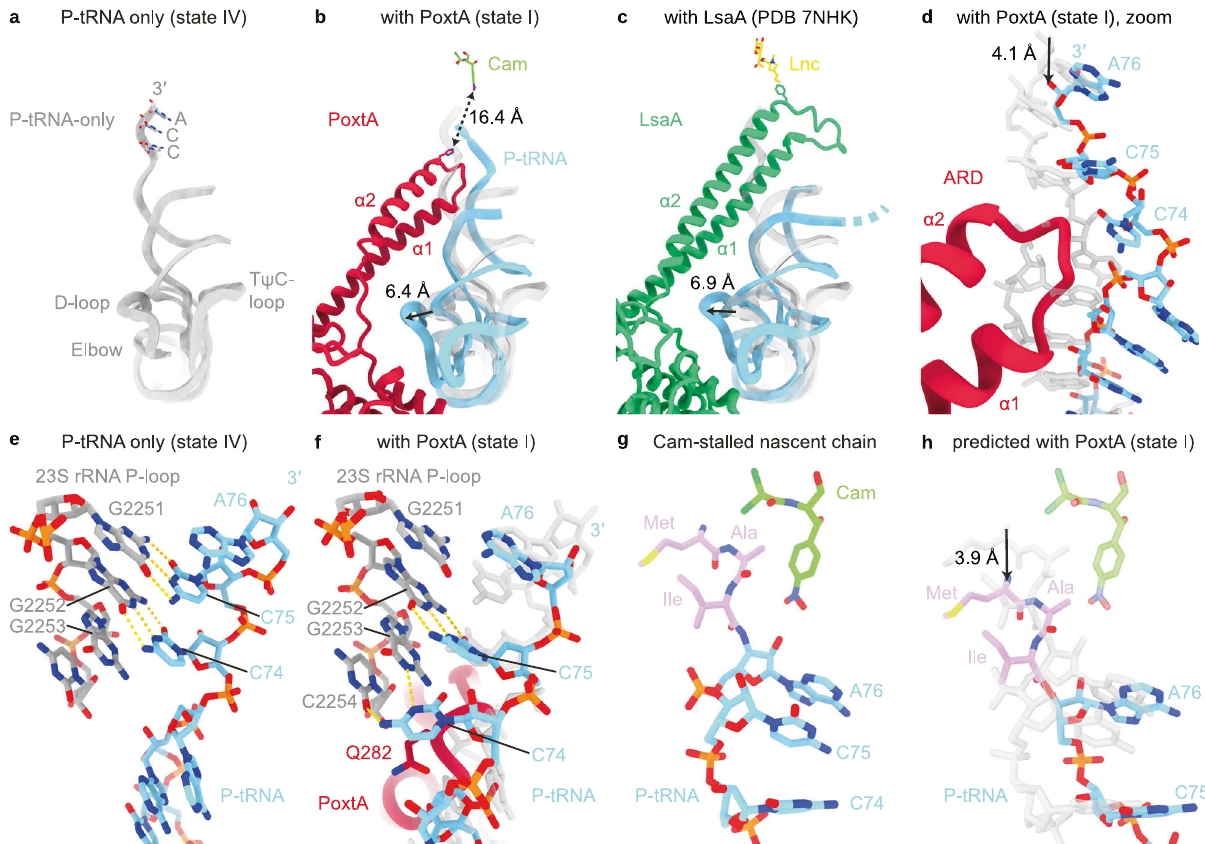
Fig. 5 PoxtA modulates the conformation of the P-tRNA. a – c Comparison of of the P-site tRNA from ( a ) E. faecalis 70S – P-tRNA only complex (grey), ( b ) PoxtA – 70S complex (state I, PoxtA in red and P-tRNA in light blue) and ( c ) LsaA – 70S complex (PDB ID 7NHK 15 , LsaA in green and P-tRNA in light blue). Models of chloramphenicol for PoxtA (PDB ID 6ND5 77 ) and lincomycin for LsaA (PDB ID 5HKV) 78 are superimposed for reference. d close-up of ( b ) showing P-tRNA acceptor stem distortion induced by PoxtA binding. e , f Interaction between the 23S rRNA P-loop (grey) and P-tRNA (light blue) for ( e ) the P-tRNA-only complex (state IV) and f with bound PoxtA (state I, state IV P-tRNA is overlayed in transparent grey for comparison). g , h Indirect modulation of the chloramphenicol binding site by PoxtA. g The structure of chloramphenicol (cam) stabilised by a nascent peptide chain with alanine in the − 1 position 39 . h Modelled shift of the nascent chain shown in g induced by PoxtA displacement of the P-tRNA CCA-end. The P-tRNA from g is overlaid in transparent grey for